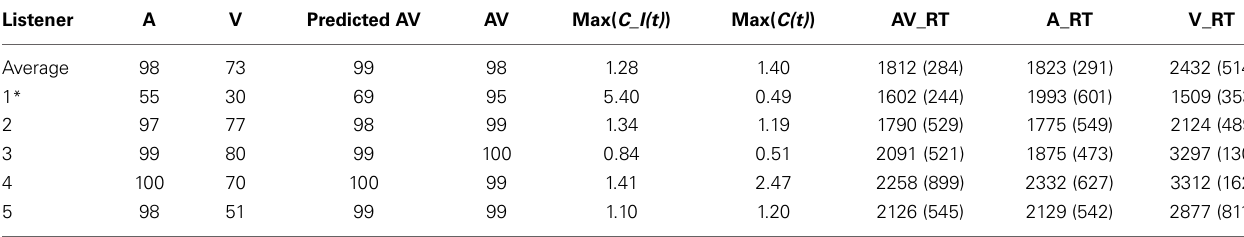
Table 3 | Speeded word recognition accuracy scores, mean RTs, and standard deviations (parentheses).